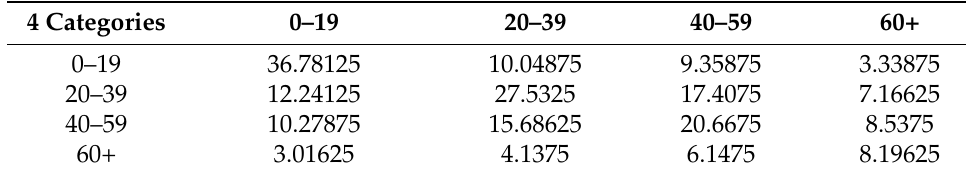
Table A2. Mossong data with 4 age